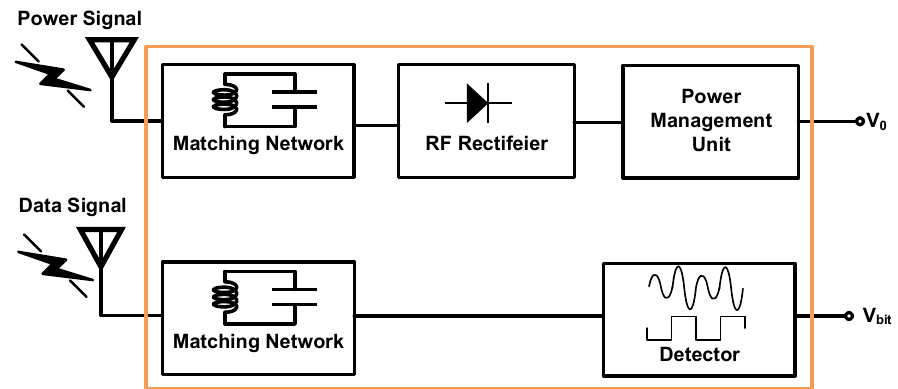
Figure 1. Block diagrams of conventional RF energy harvestor and data receiver system.